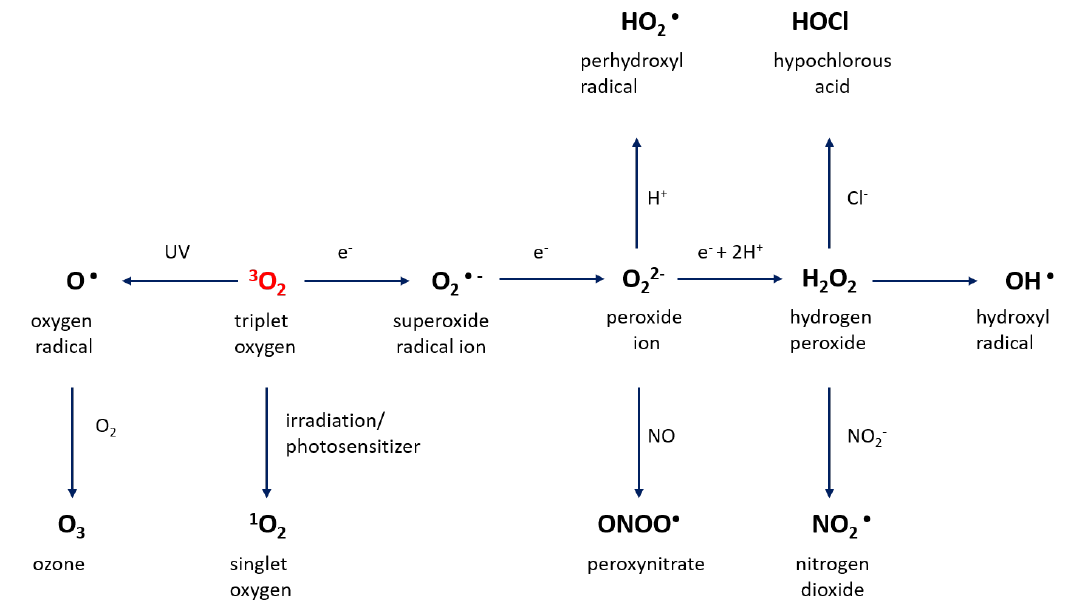
Figure 1. Schematic of primary reactive oxygen species (ROS) production mechanism.